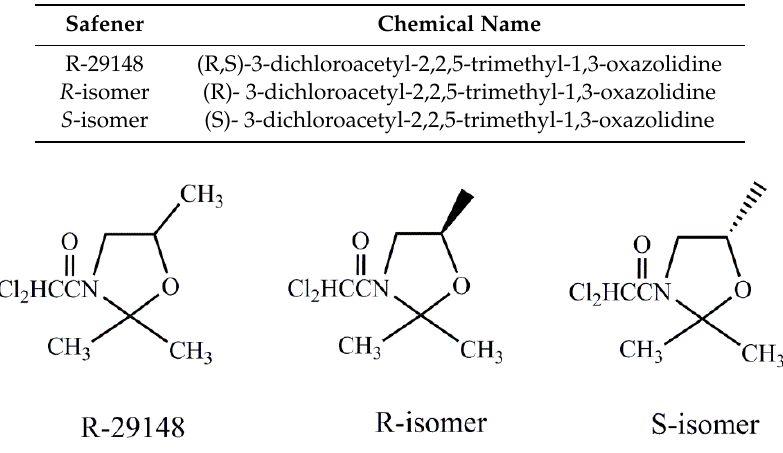
Figure 5. R -29148, R -isomer, and S -isomer employed in the test as potential safeners.